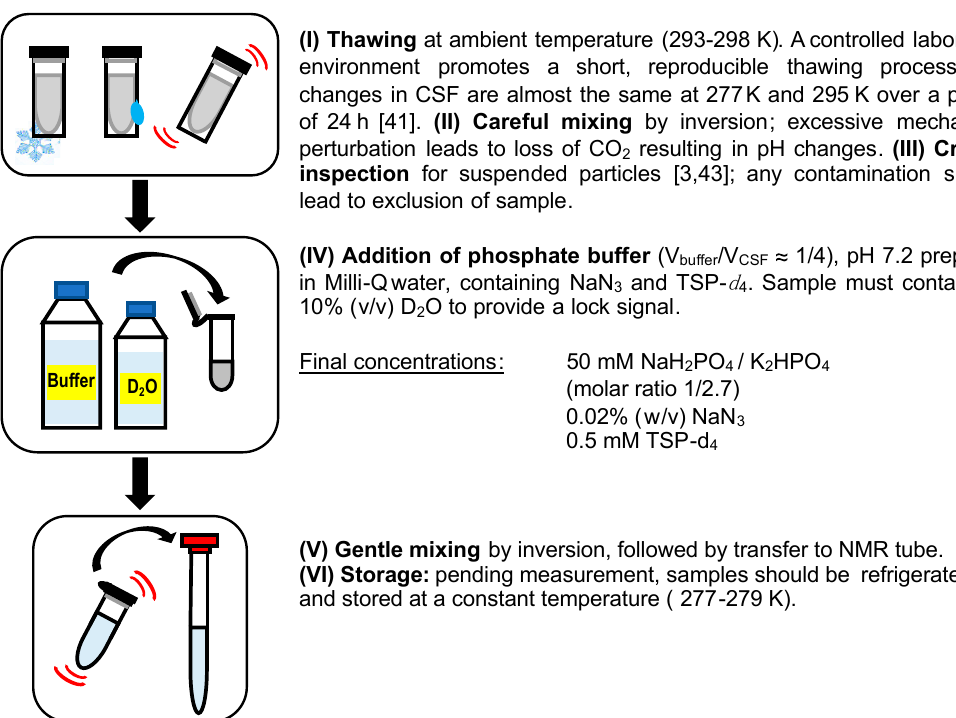
Figure 3. Stack plot of two spectral regions of the proton spectra of 10 CSF samples prepared as described in text showing consistency of metabolite resonances typically affected by differences in ionic strength and pH (600 MHz, 298 K, phosphate buffer 50 mM, pH 7.30–7.69, 10% D 2 O, line broadening = 0.5 Hz). Note: For compound abbreviations, see Table 2.